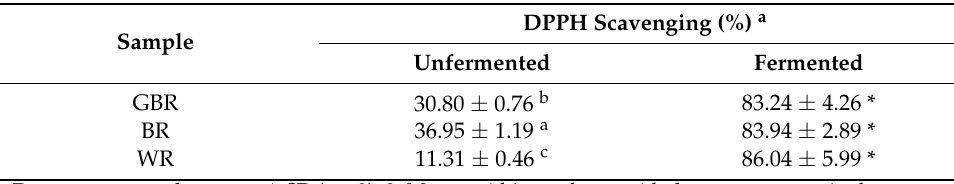
Table 5. Effect of fermentation on the DPPH-scavenging (%) of rice samples.